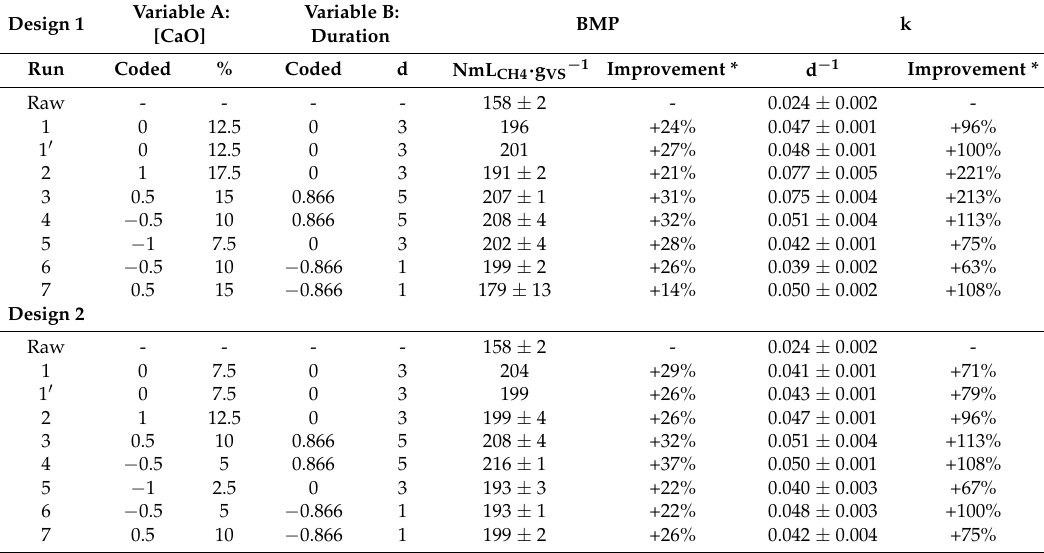
* by comparison with raw (i.e., non-pretreated)